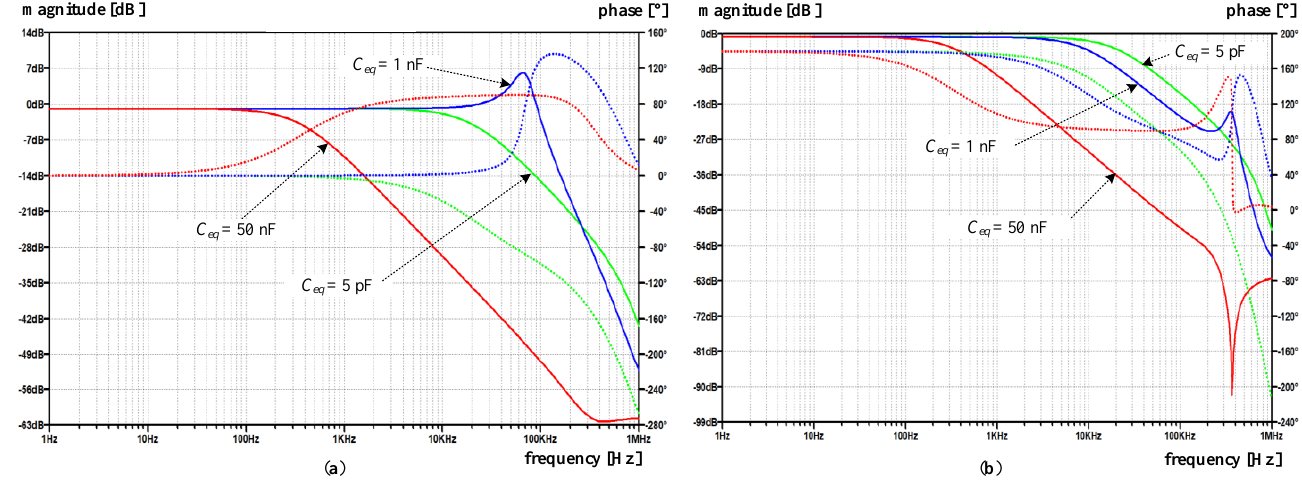
Figure 8. Simulated frequency response Y (magnitude-solid line, phase — dotted line) with original and modified amplifier for varying C eq : ( a ) original amplifier; ( b ) modified amplifier.